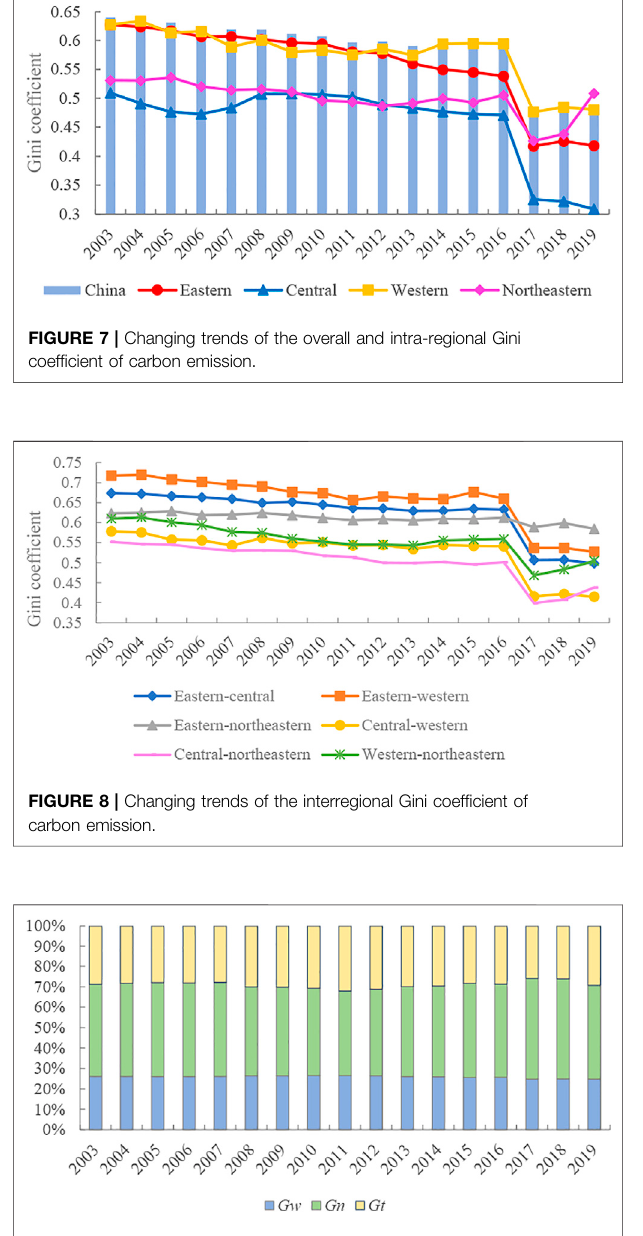
FIGURE9| Sourcesoftheoveralldifferencesincarbonemissionandthe trends of their distributions.